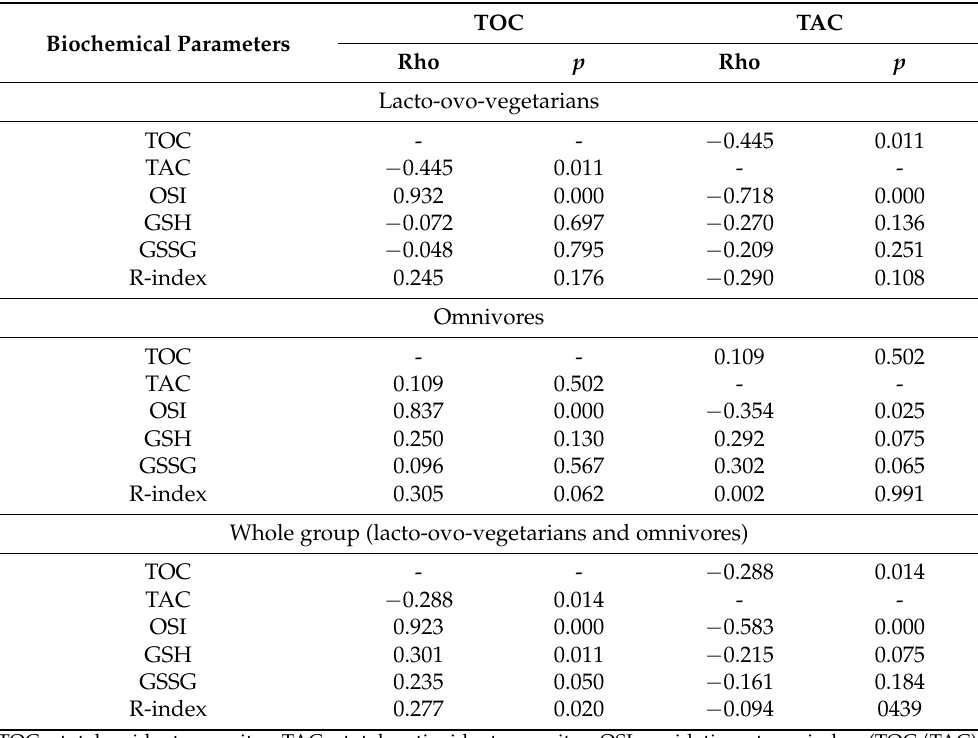
Table 4. Correlations between antioxidants parameters in vegetarian and omnivorous as well as in the whole group of children. Biochemical